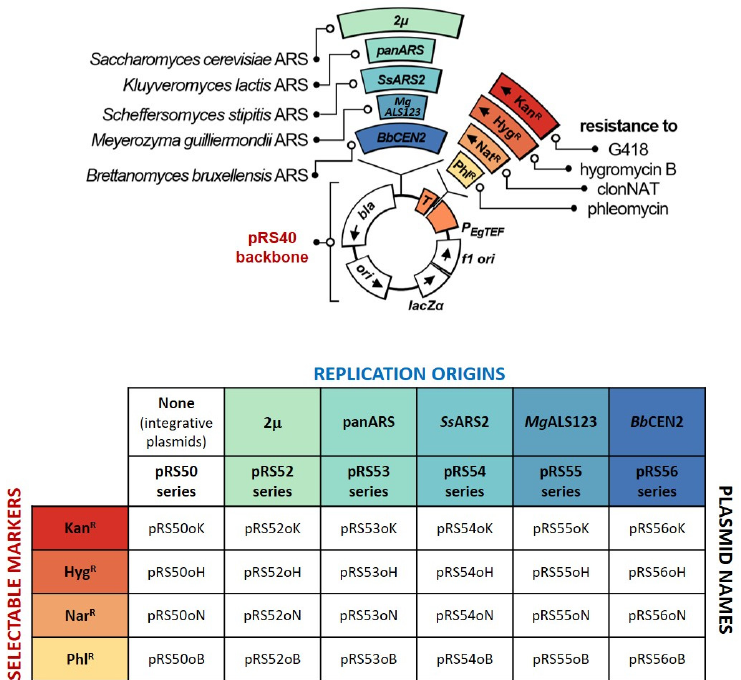
Figure 3. Schematic representation of integrative and replicative yeast plasmids constructed in this work and their names and main features. The pRS40 backbone carries sequences for selection and maintenance in E. coli (ori, bla) and other common vector features ( LacZ α , f1 ori ), as well as TEF promoter (P Eg TEF ) and terminator (T) from Eremothecium gossypiii for expression of antibiotic selectable markers in yeasts. Codon usage optimized markers conferring resistances to geneticin G418 (Kan R ), hygromycin B (Hyg R ), cloNAT (Nar R ) or phleomycin (Phl R ) were cloned under the regulation of the TEF promoter thus creating four different yeast integrative plasmids. Additionally, in each of these plasmids, the following origins of the replications were cloned: 2 µ form Saccharomycer cerevisiae , panARS form Kluyveromyces lactis , Ss ARS2 from Scheffersomyces stipitis , Mg ALS123 form Merozyma guilliermondii or Bb CEN2 from Brettanomyces bruxellensis , thus creating a set of 20 replicative yeast plasmids.